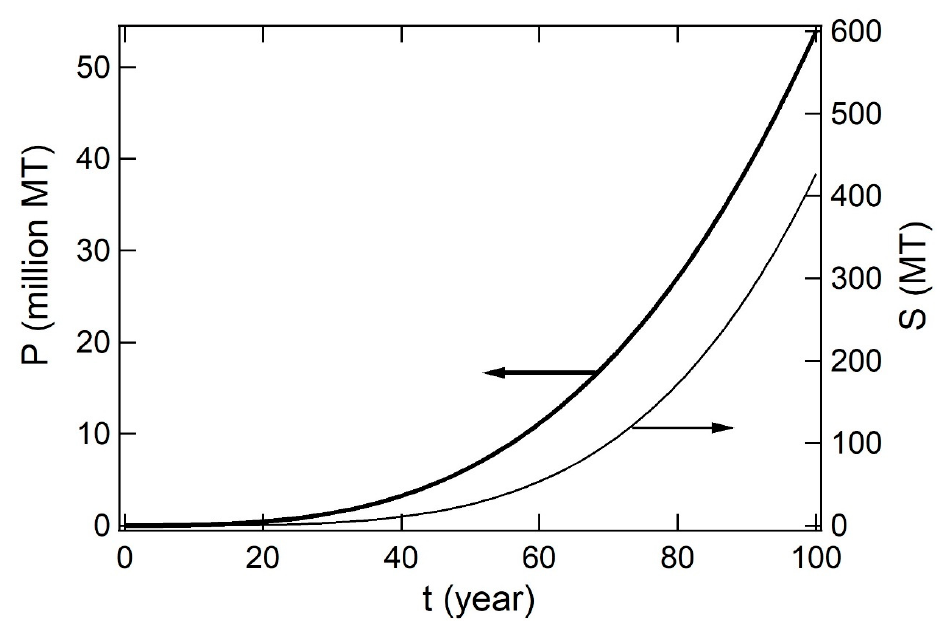
Figure 6. Simulated amounts of (P, left) PS debris and generated (S, right) SOs that have been accumulated in oceans at time t (year) since 1950 to 2050.